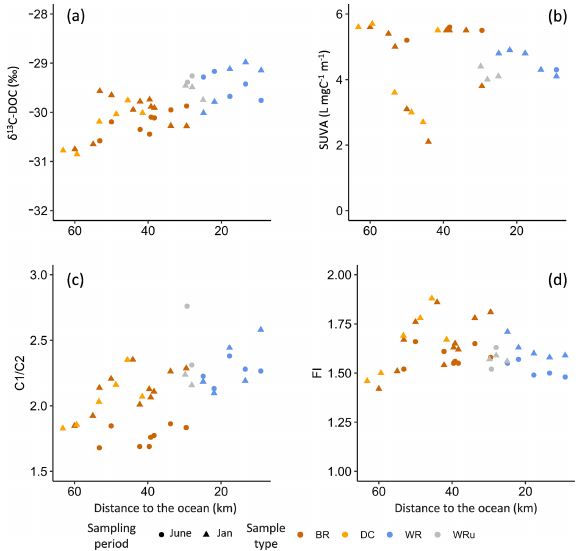
Figure 3. Evolution of DOM along the blackwater river to the ocean continuum. (a) δ 13 C-DOC. (b) SUVA – specific UV absorbance – index. (c) C1 / C2. (d) FI – fluorescence index.